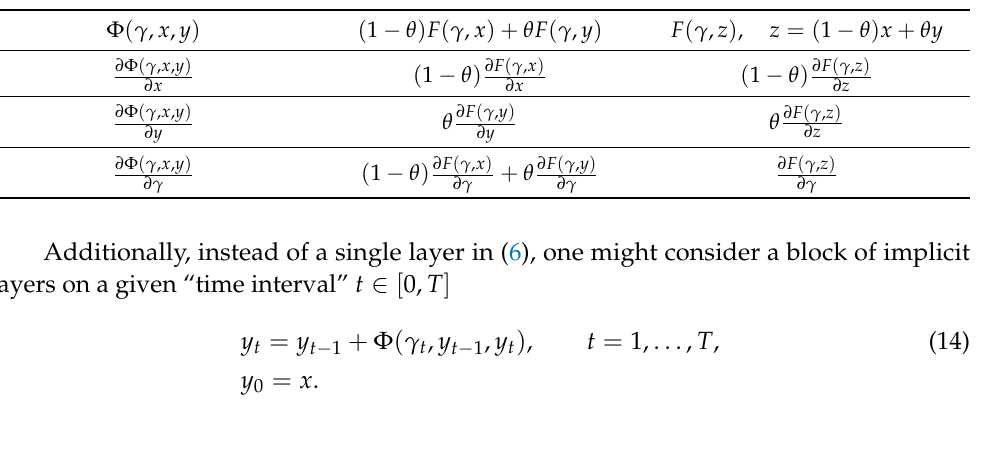
Figure 3. Stability regions (grey) and the contours of the stability function of implicit residual layers; the corresponding regions where layers are contractive are shown in red while the hatched circles contain the spectrum of the spectrally normalized 1-Lipschitz function F ( γ , x ) . Table 1. Derivatives of the nonlinear maps in (11) and